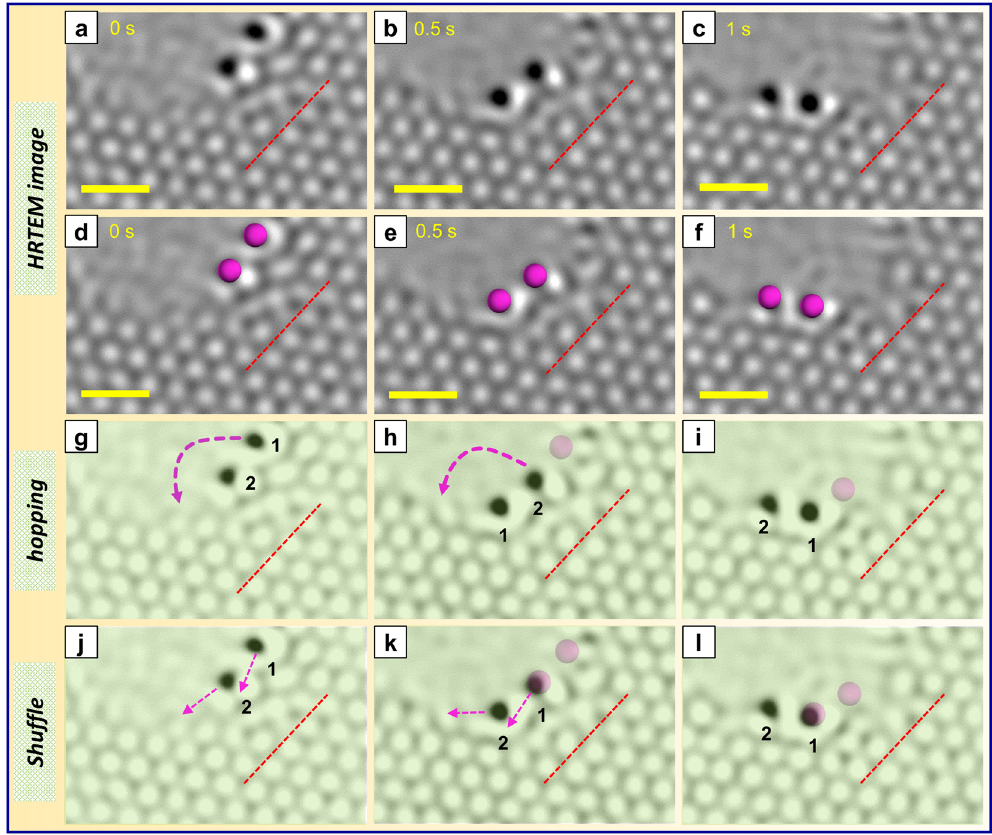
Fig. 7 Activity of an Sn dimer along a graphene edge under electron irradiation. a – c HRTEM images showing binary atoms activity. d – f HRTEM images with partial ball models to aid viewing. g – i HRTEM images showing possible atom hopping activity. j – l HRTEM images showing possible atom shuf fl e activity. The rose-red balls indicate the Sn atom, and the translucent rose-red balls represent the previous positions of the Sn atom. Dose ca. 1.8 × 10 6 A/m 2 , and all scale bars are 0.5 nm. Reproduced with permission from Wiley-VCH GmbH 48 .